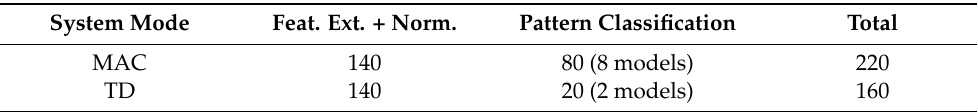
Table 7. Computational time of the system modules (in milliseconds). ‘MAC’ stands for machine + ac- tivity identification mode, TD for threat detection mode, and ‘Feat. Ext. + Norm.’ for Feature extraction +